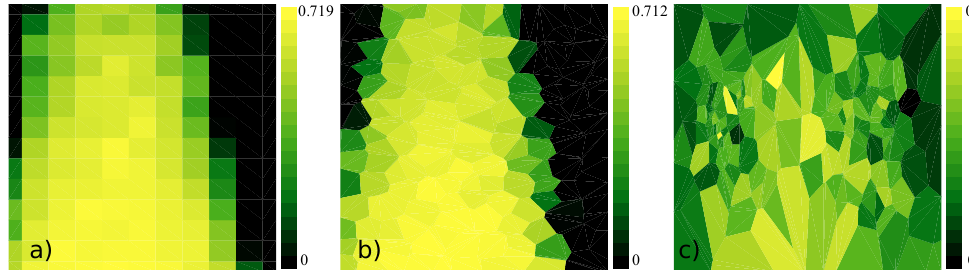
Figure 5. Degree of the network of the flow generated with START for grid (a) , grid with jitter (b) and two clusters (c) .